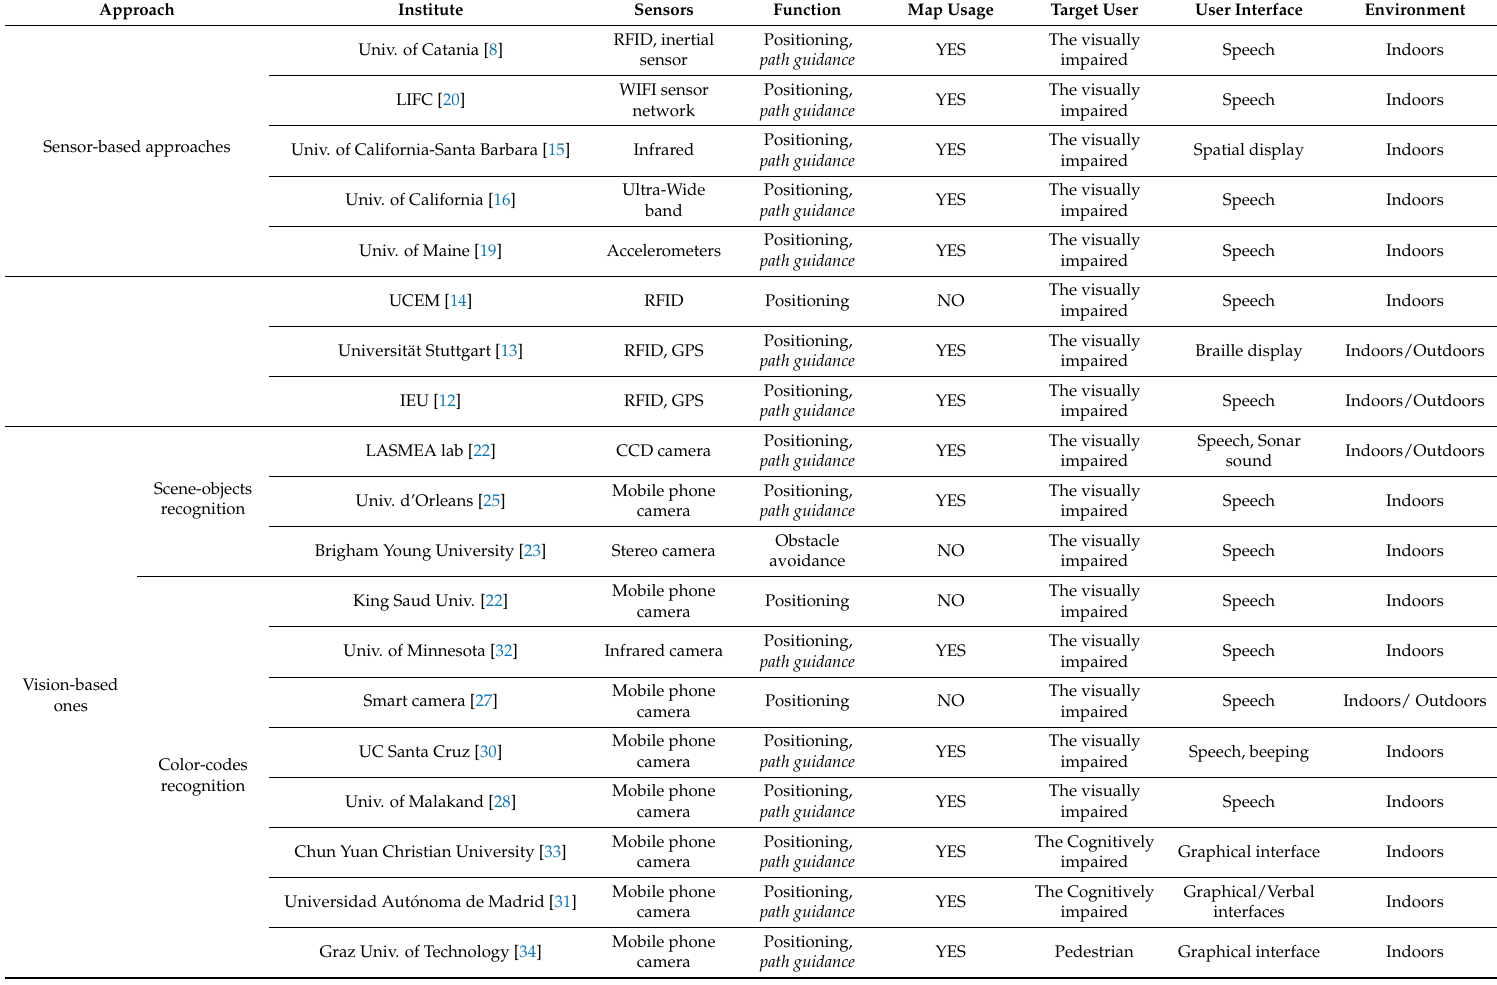
Table 1. Existing systems for indoor